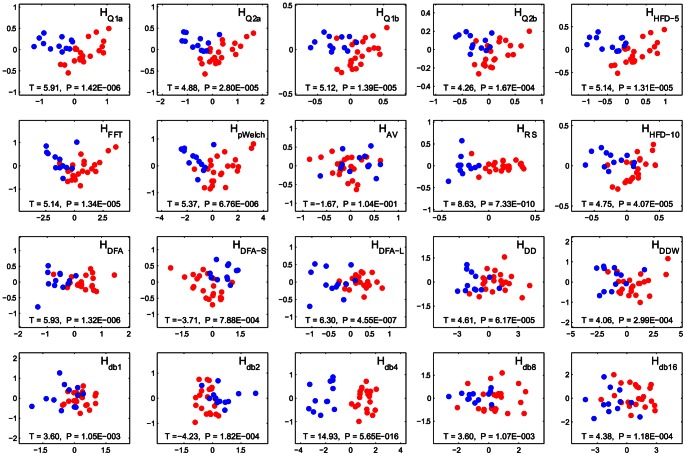
Strong scanner differences illustrated through principal components analysis.The red and blue points correspond to sets of subjects scanned on different scanners with the same task (BL-ANT). Each of the plots show the distribution of subjects along the first (x-axis, arbitrary units) and second (y-axis, arbitrary units) principal components of a matrix of Hurst region averages by subject. Each of the Hurst estimates was computed for the d-m-bcw-fhi processed average time series of every region of WFU pickAtlas. The t- and p-values represent differences between scanners along the first principal component (x-axis).